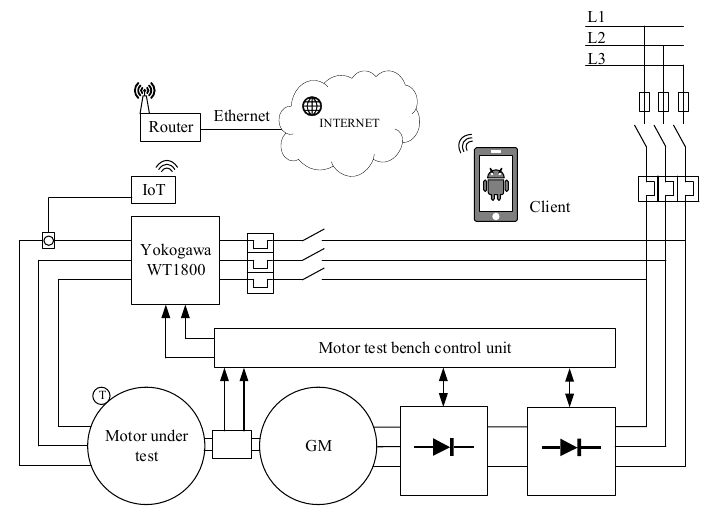
Figure 10. The block diagram of the test bench.